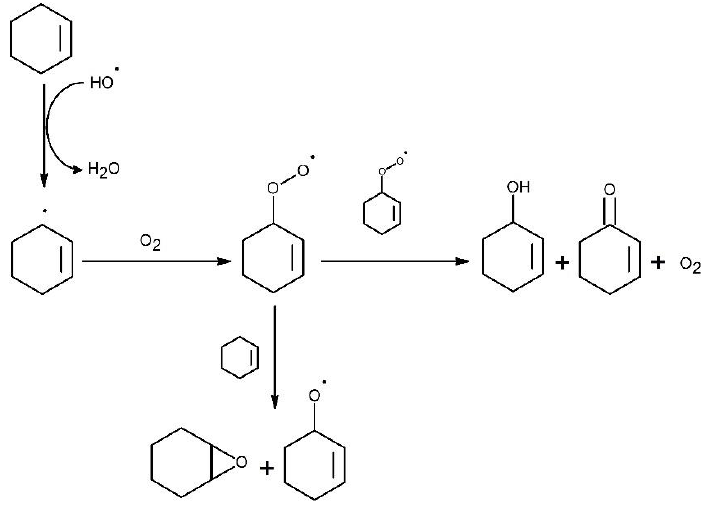
Figure 6. Proposed pathways for the oxofunctionalization of cyclohexene over titanium dioxide- and bismuth oxyhalide-based photocatalysts. Table 4. Product selectivity of the photocatalytic oxofunctionalization of cyclohexene over the synthesized photocatalysts.